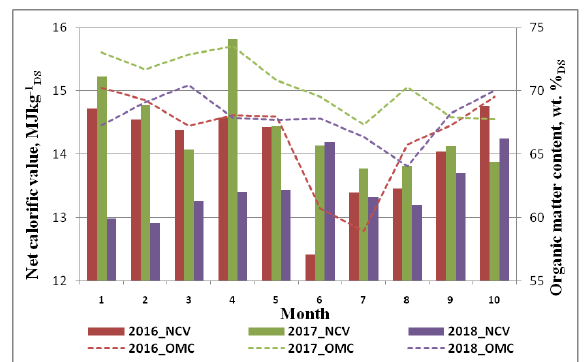
Figure 5. Fluctuations of NCV and